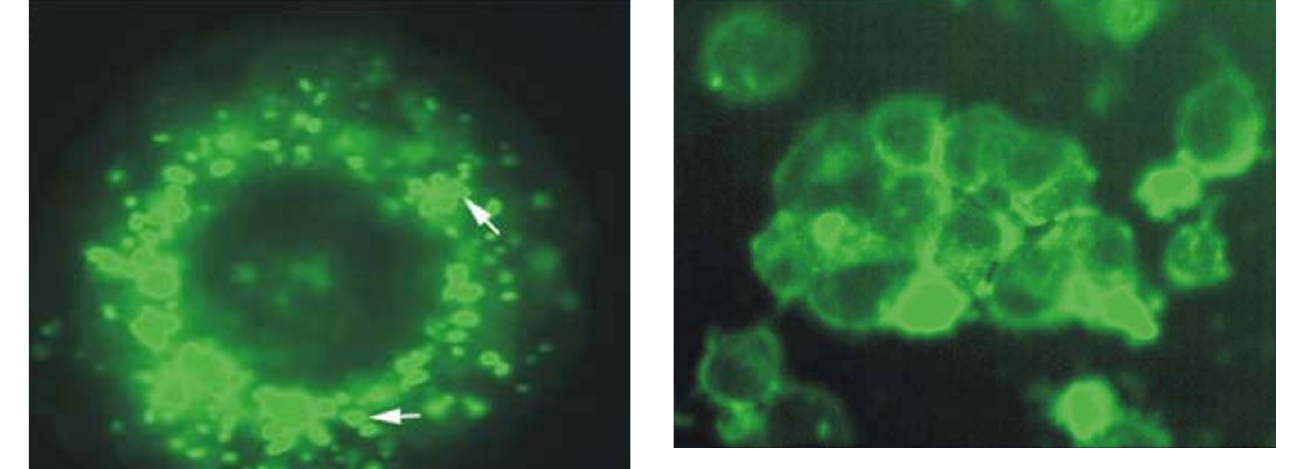
Figure 3 Aggregated insect cells after transfection with wild type P0/GFP fusion in vector pEXII. The fluorescent cell surface indicates the membrane incorporation of the wild type P0-GFP fusion protein which initiates the enhanced cell- cell agglutination.